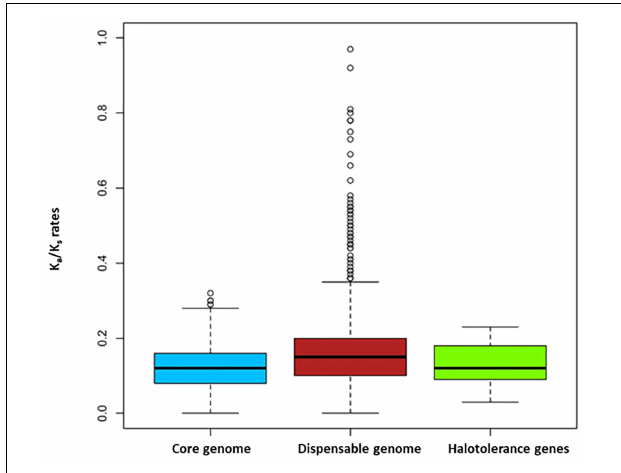
FIGURE 4 | Boxplot of K a /K s ratios of core-genome (blue), dispensable-genome (red) and halotolerance genes (green).